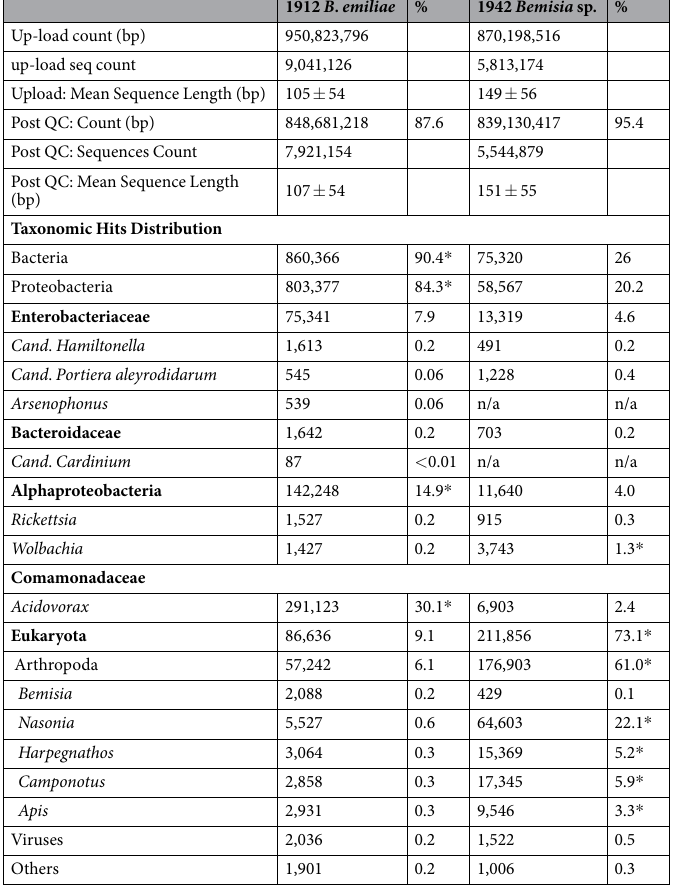
Table 1. MiSeq input and post quality control (QC) data for metagenomic analysis via MG-Rast standard pipeline for the 1912 B . emiliae specimen (MG-Rast accession number: 4681440.3) and the 1942 Japanese Bemisia species (MG-Rast accession number: 4690946.3). A summary of taxonomic hits for Bacteria, Eukaryota, Viruses are provided. Hit abundances that differed greatly between B . emiliae and the 1942 Bemisia sp. are indicated in by ‘ *